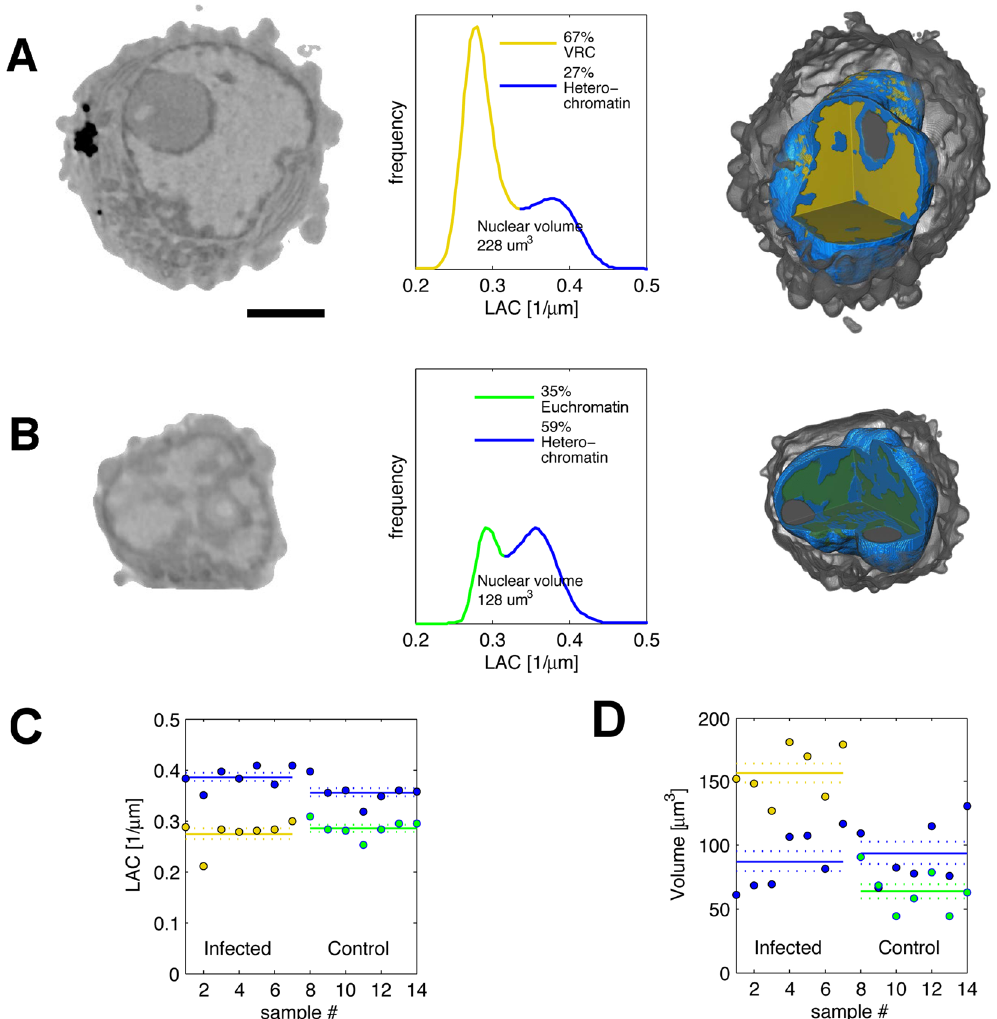
Figure 3. Virus-induced compaction and re-organization of the host chromatin. Nuclear volume of infected cells ( A ) was increased compared with non-infected cells ( B ) to accommodate VRC, as seen in SXT orthoslices (left) LAC-histograms plotting number of voxels with specific LAC values (centre), and 3D views of segmented and color-coded nuclei (right). Scale bar, 3 µ m. ( C ) Nuclear LAC values and ( D ) volumes of heterochromatin (blue) and VRC (yellow) of infected cells (n = 7) and volumes of heterochromatin (blue) and euchromatin (green) of non-infected cells. Solid lines represent the mean and dotted lines the mean ± SEM. See also Supplementary Movie